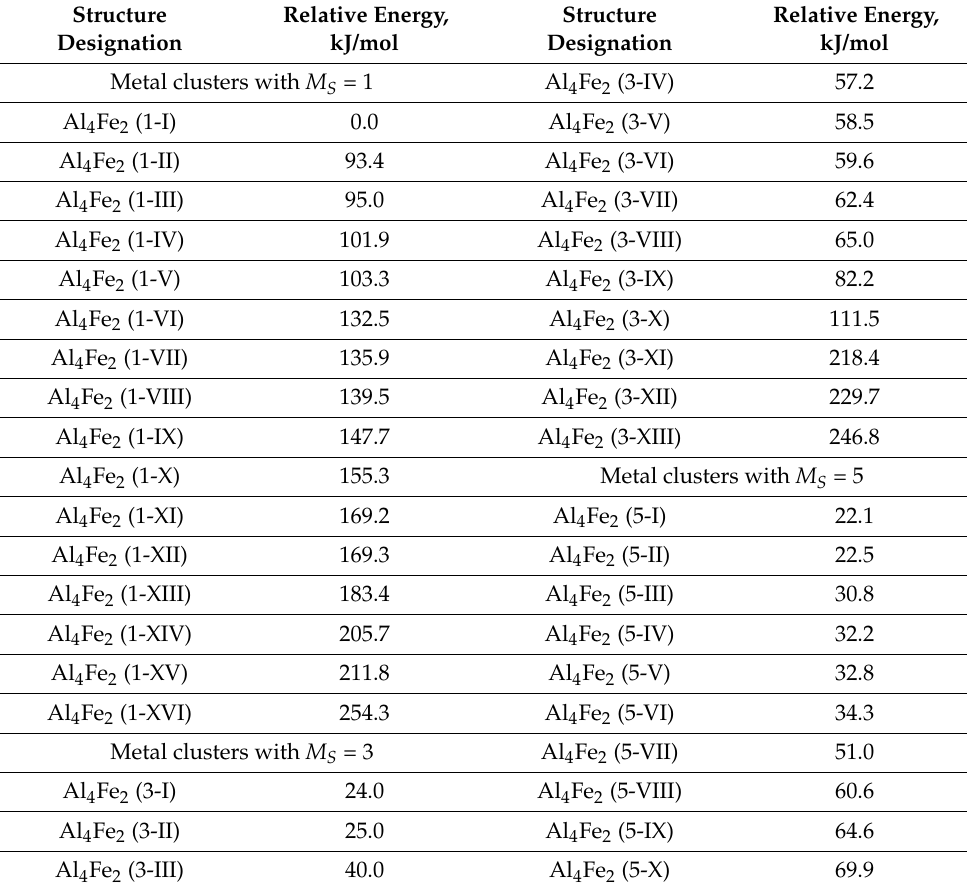
Table 3. Relative energies and spin multiplicities of the ground states of various structural isomers of metal clusters with an Al 4 Fe 2 composition.